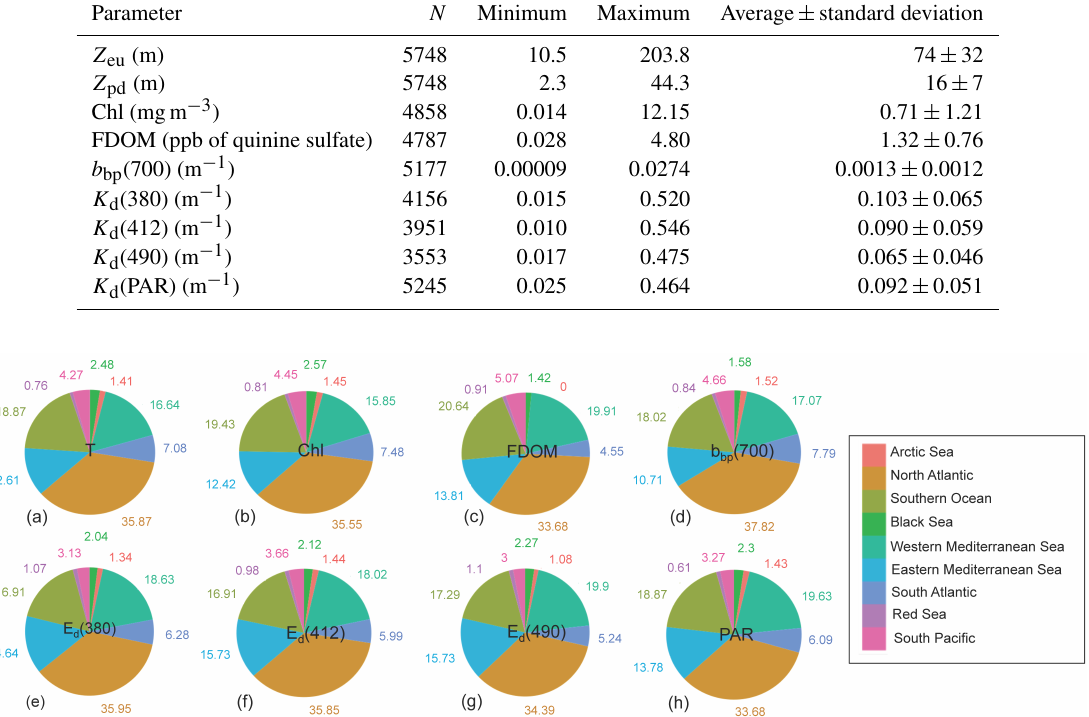
Figure 8. Relative contributions (%) of the 9837 vertical profiles among nine regions and subregions sampled by Biogeochemical-Argo floats: (a) temperature ( T ), (b) chlorophyll a concentration (Chl), (c) fluorescent dissolved organic matter (FDOM), (d) particulate backscat- tering coefficient at 700nm ( b bp (700)), (e) downward irradiance at 380nm ( E d (380)), (f) downward irradiance at 412nm ( E d (412)), (g) downward irradiance at 490nm ( E d (490)), and (h) photosynthetically available radiation (PAR). See Appendix A for basins included within each region and/or